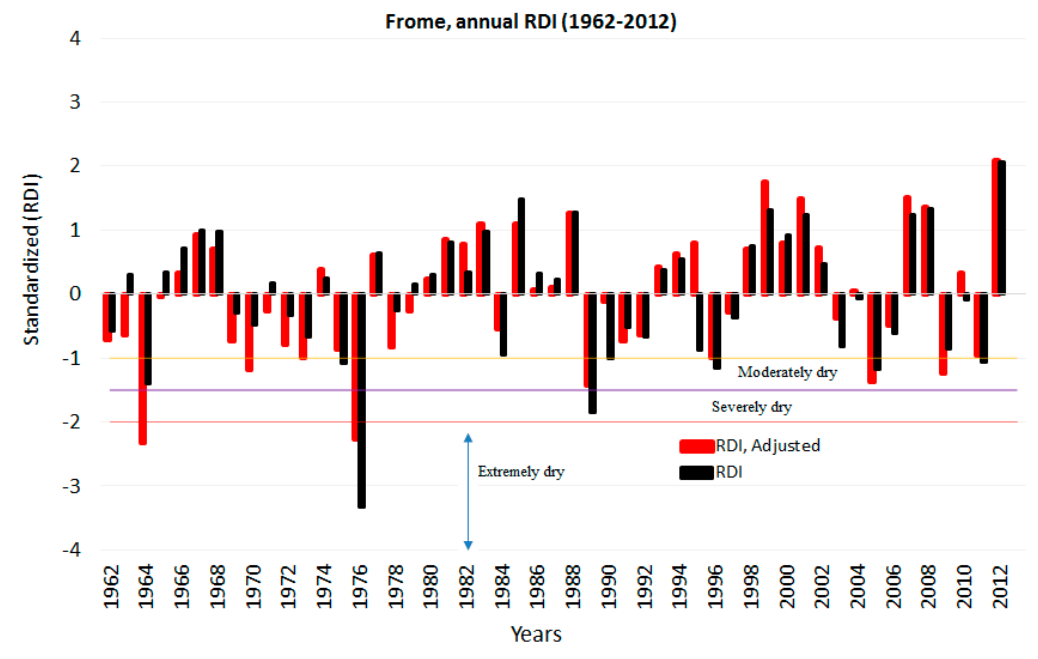
Figure 9. Historic annual reconnaissance drought index (RDI) of the Frome catchment from 1961 to 2012.